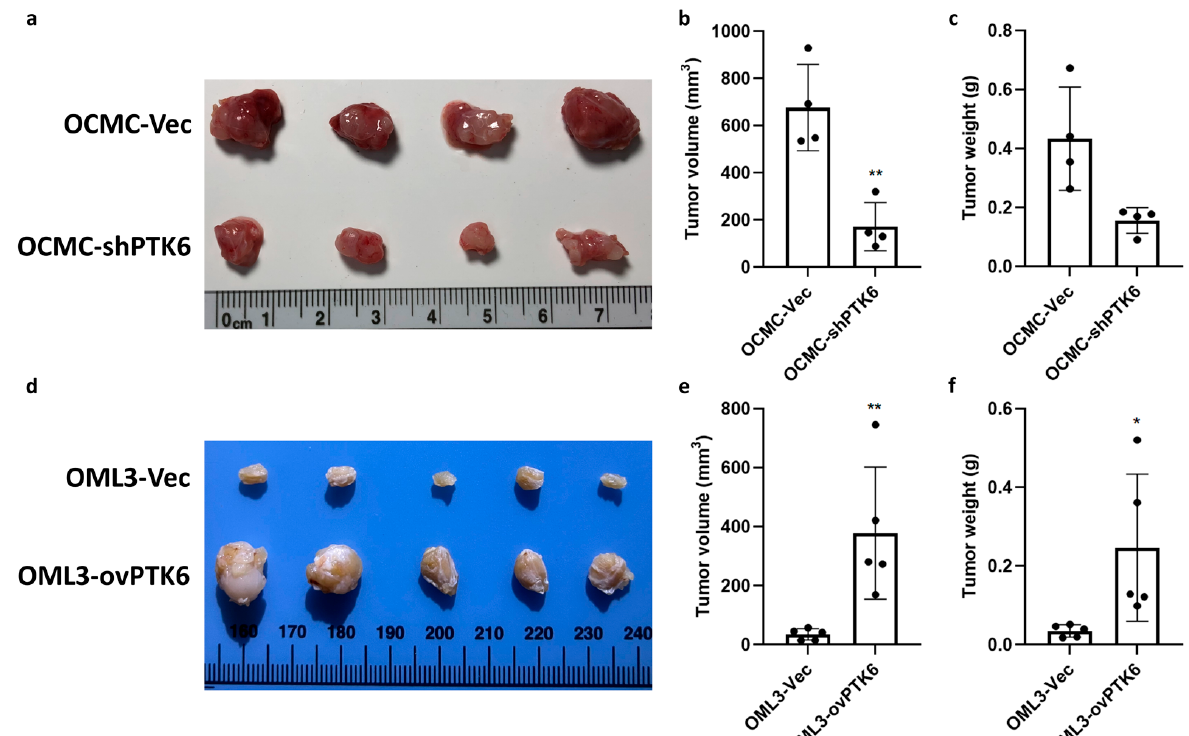
Figure 5. PTK6 promoted tumorigenesis in vivo. ( a ) Images show the sizes of tumors collected from control and PTK6 knockdown xenograft tumor models. ( b , c ) Tumor volumes and weights at 4 weeks post injection were measured. ( d ) Images show the sizes of tumors received from control and PTK6 overexpression xenograft tumor models. ( e , f ) Tumor volumes and weights at 8 weeks post injection were measured. Tumor volume was calculated using the following formula: TV (mm 3 ) = (L × W 2 )/2. * p < 0.05. ** p < 0.01.